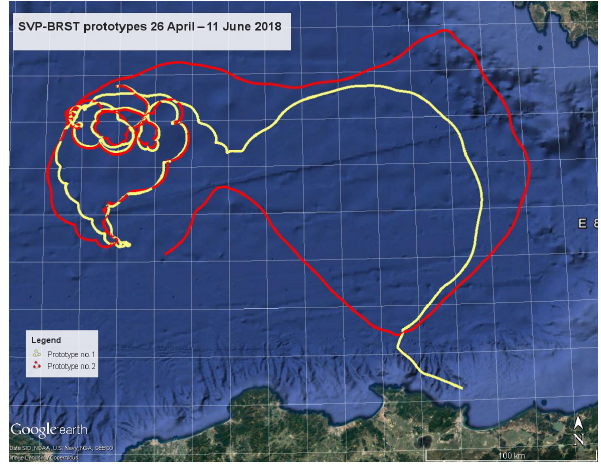
Figure 7. Trajectories of the two SVP-BRST prototypes after de- ployment on 26 April 2018. The two buoys separated on 22 May 2018. Map data: SIO, NOAA, US Navy, NGA, GEBCO; map im- age: